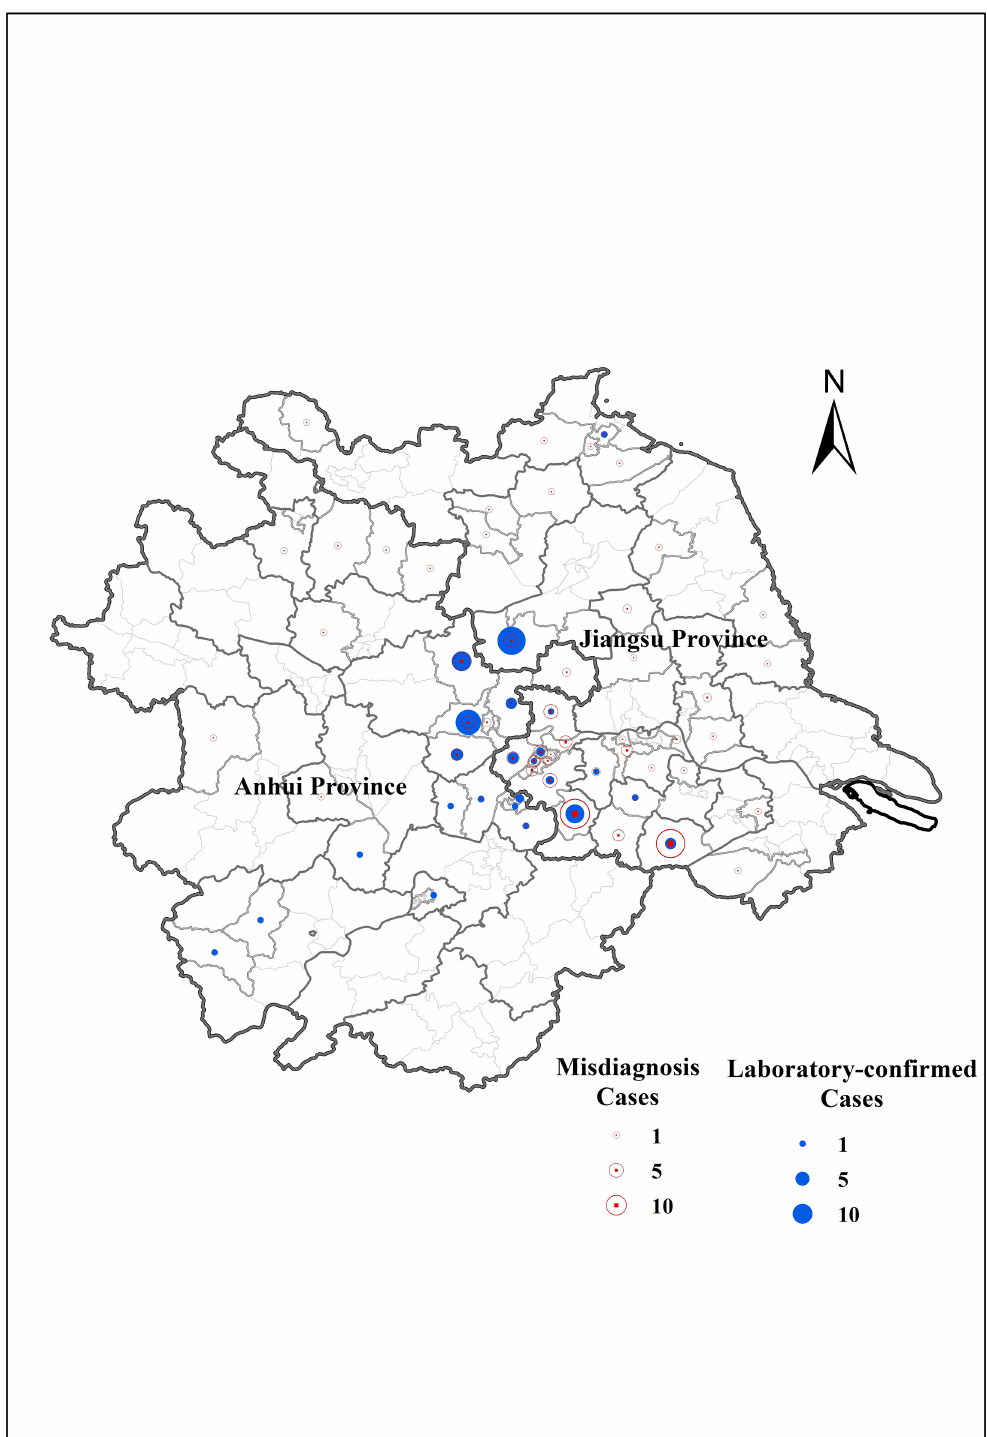
Fig 2. The spatial distribution of laboratory-confirmed caseswith SFTSV infection and misdiagnosis cases in Jiangsu Province, China, 2011–2013. The figure was generatedusing ArcGIS software version9.3 (ESRI, Redlands,CA, USA). The blue circle denotesthe laboratory-confirmed cases, and the red circle denotes the misdiagnosis cases, where the size of the circle means the approximate number. The bold line is the boundary of JiangsuProvince (Up right) and Anhui Province (Down